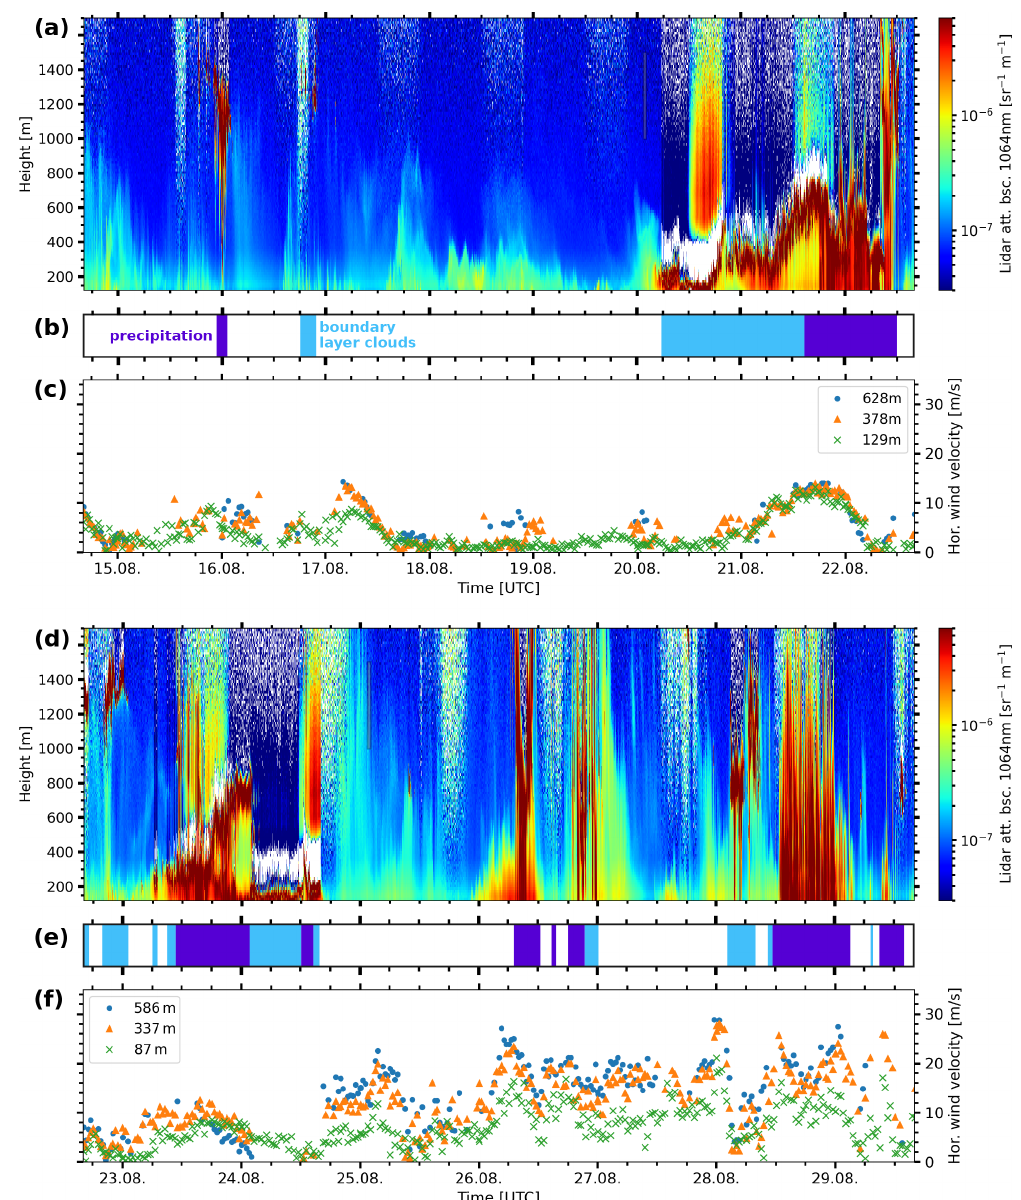
Figure 7. Overview of aerosol and cloud conditions at Punta Arenas during which sample 11 and 12 were collected. (a, d) Time-height cross-section of attenuated backscatter at 1064nm at 30s temporal and 14.9m vertical resolution obtained from the ceilometer. (b, e) Periods of boundary layer clouds and precipitation derived from the Cloudnet target classification. (c, f) Horizontal wind velocity retrieved from the Doppler lidar scans at heights of 129, 378, and